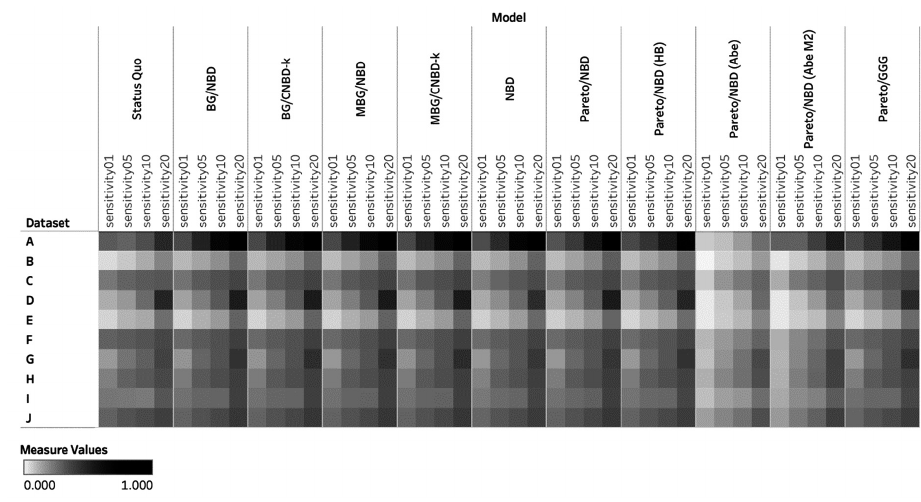
Figure 4. Results for Sensitivity (customer-level, in %) for online stores